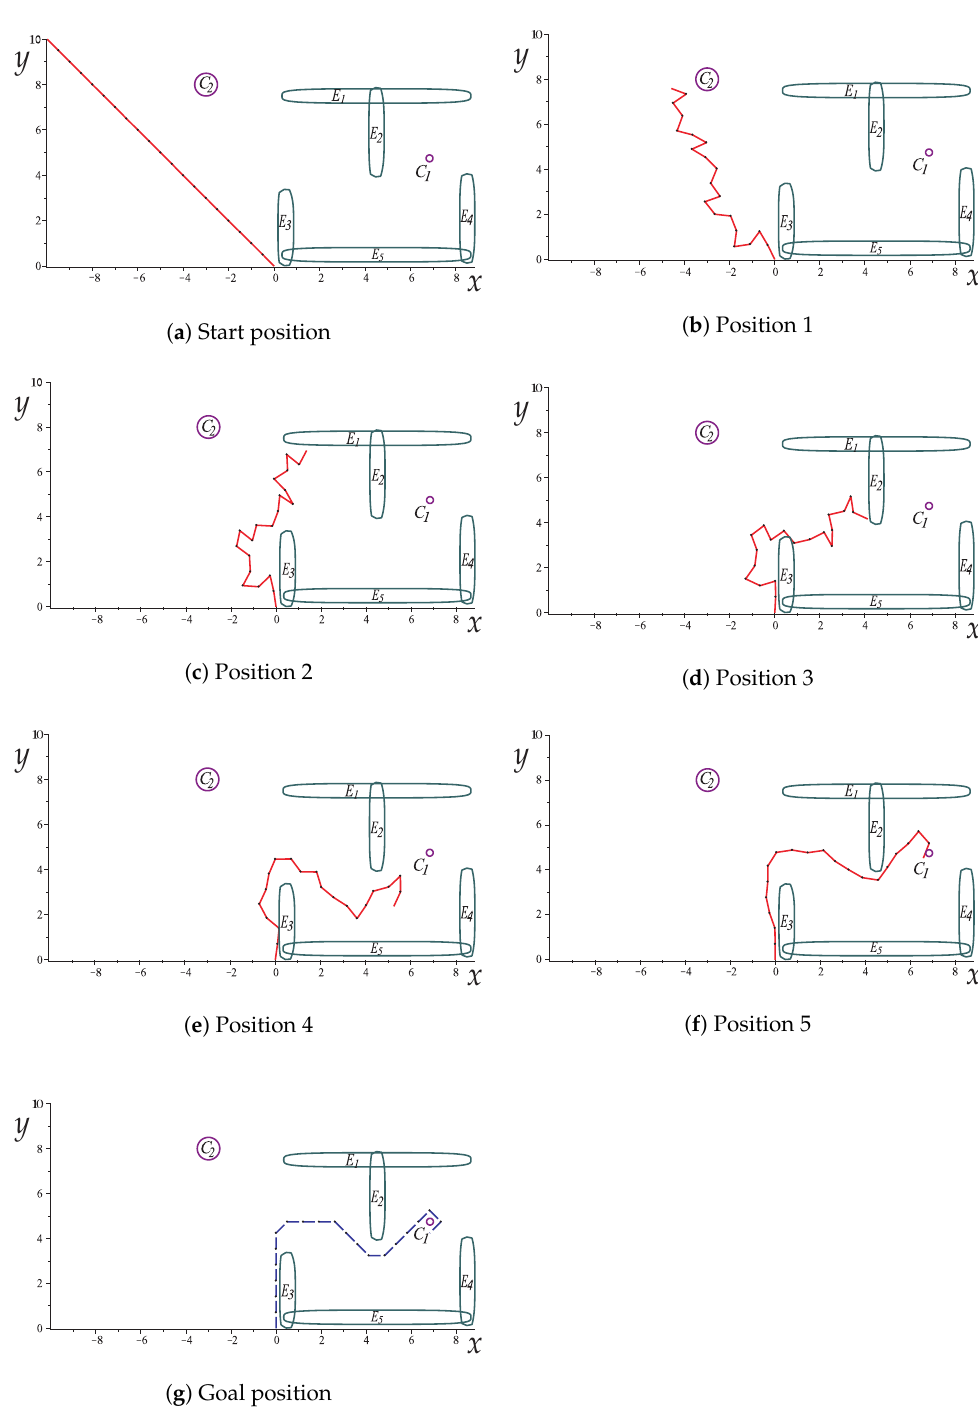
Figure 19. The sequence of images that describe the collision-free path of Case Study 3. Figure 20 shows the evolution of the angles w along the path obtained for this. It can be seen that it exhibits a smooth displacement throughout the points that correspond to the images in Figure 21. The smoothness of the path can be validated by the nature of the homotopy continuation methods, which generate a continuous solution curve. Figure 21 shows the change in joint angle movement, where it is observed that the greatest change obtained between each movement does not exceed 0.02 radians for the full path, so the path is